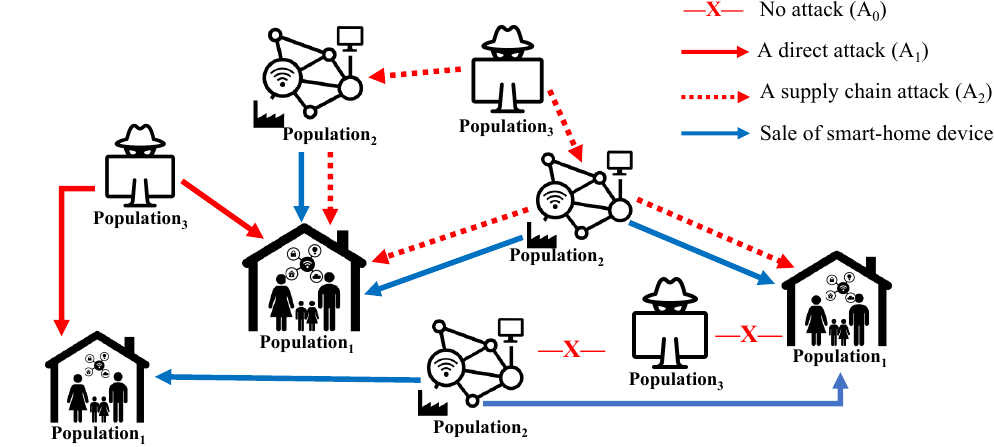
Figure 2. Illustration of the proposed system model.